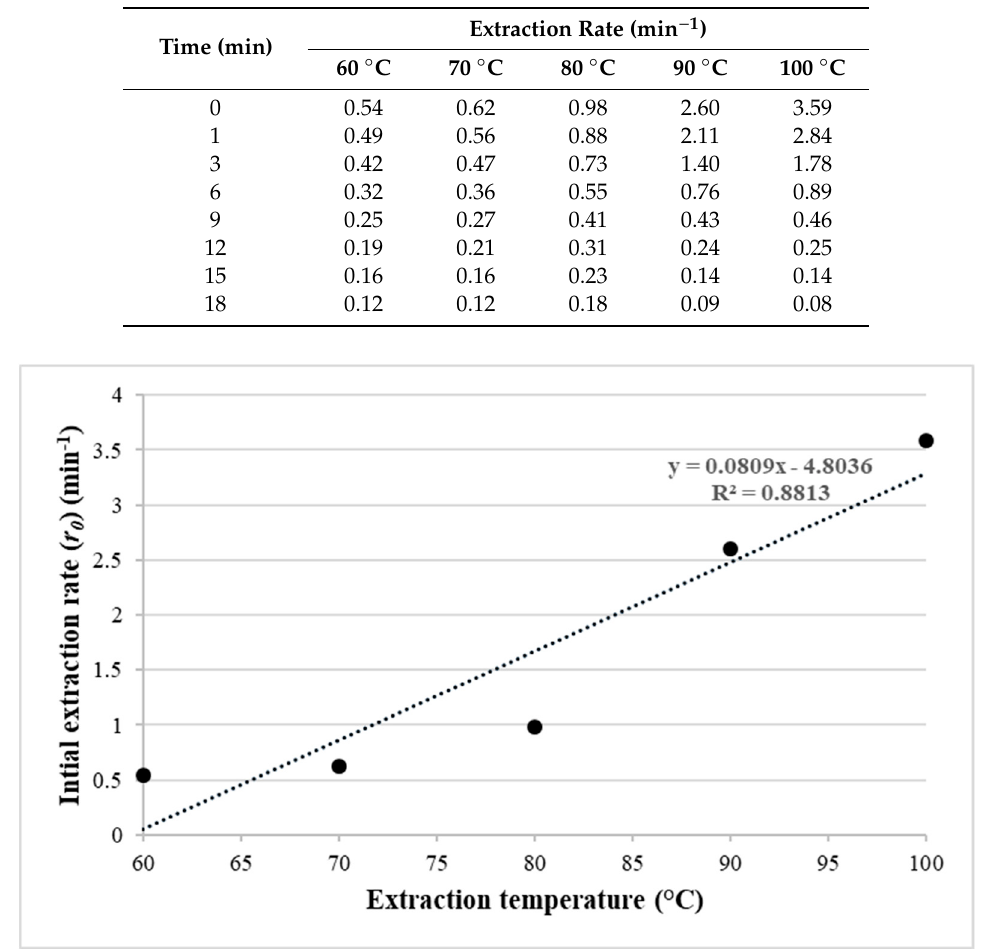
Table 5. The variation in the extraction rate of Nannochloropsis sp. microalgal lipid according to time at different MAE temperature.